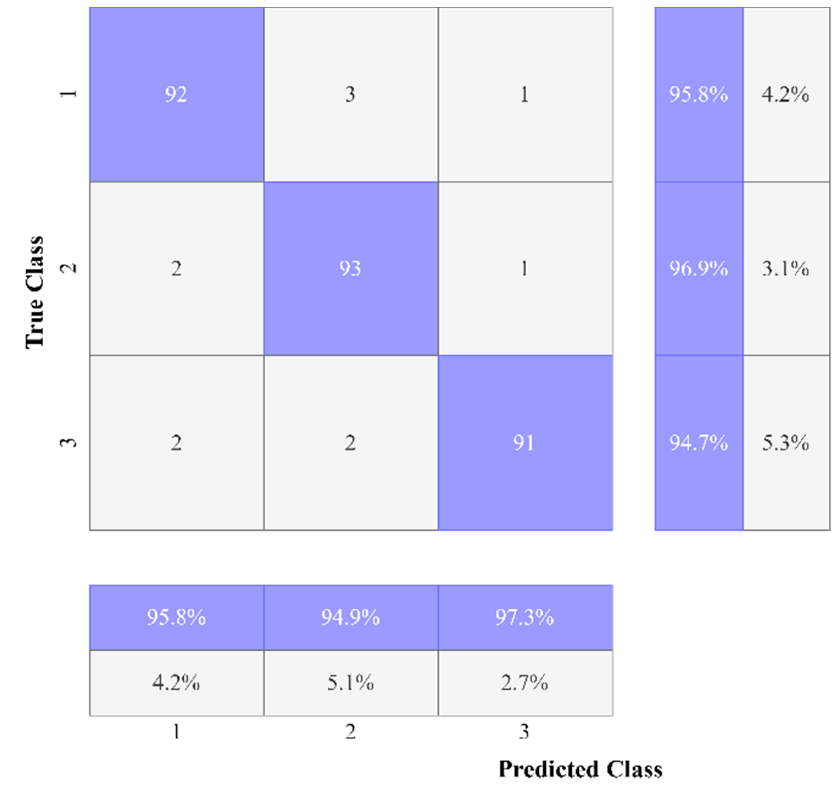
Figure 15. Confusion matrix of IGWO-IV3.